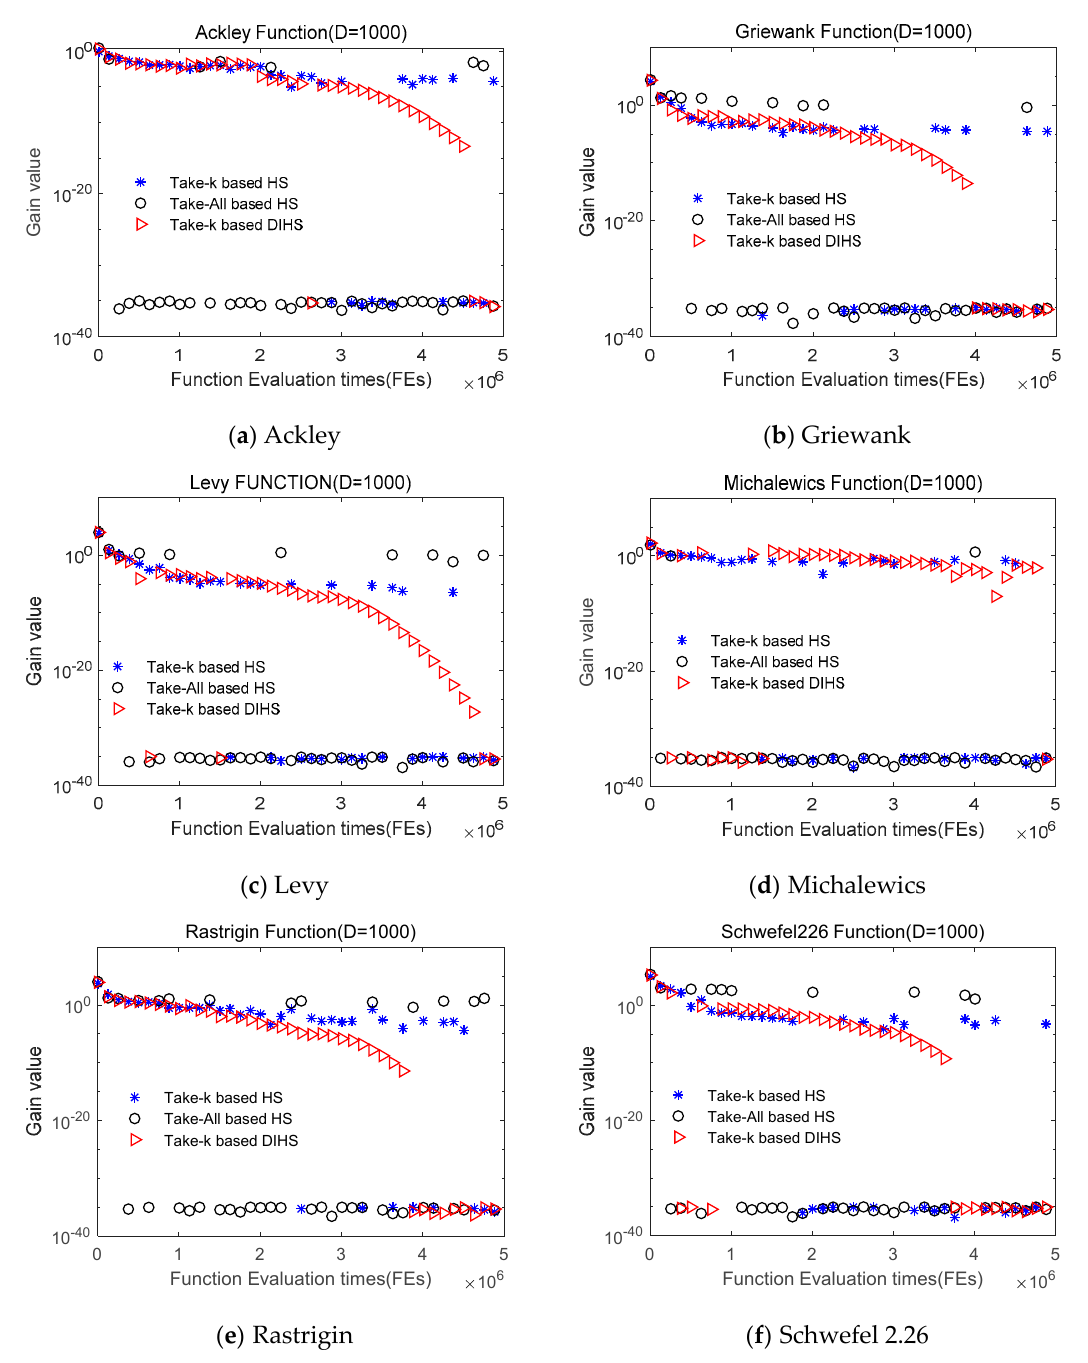
Δ of three algorithms during the search process. Figure 6. Gain value G ( ∆ t ) of three algorithms during the search